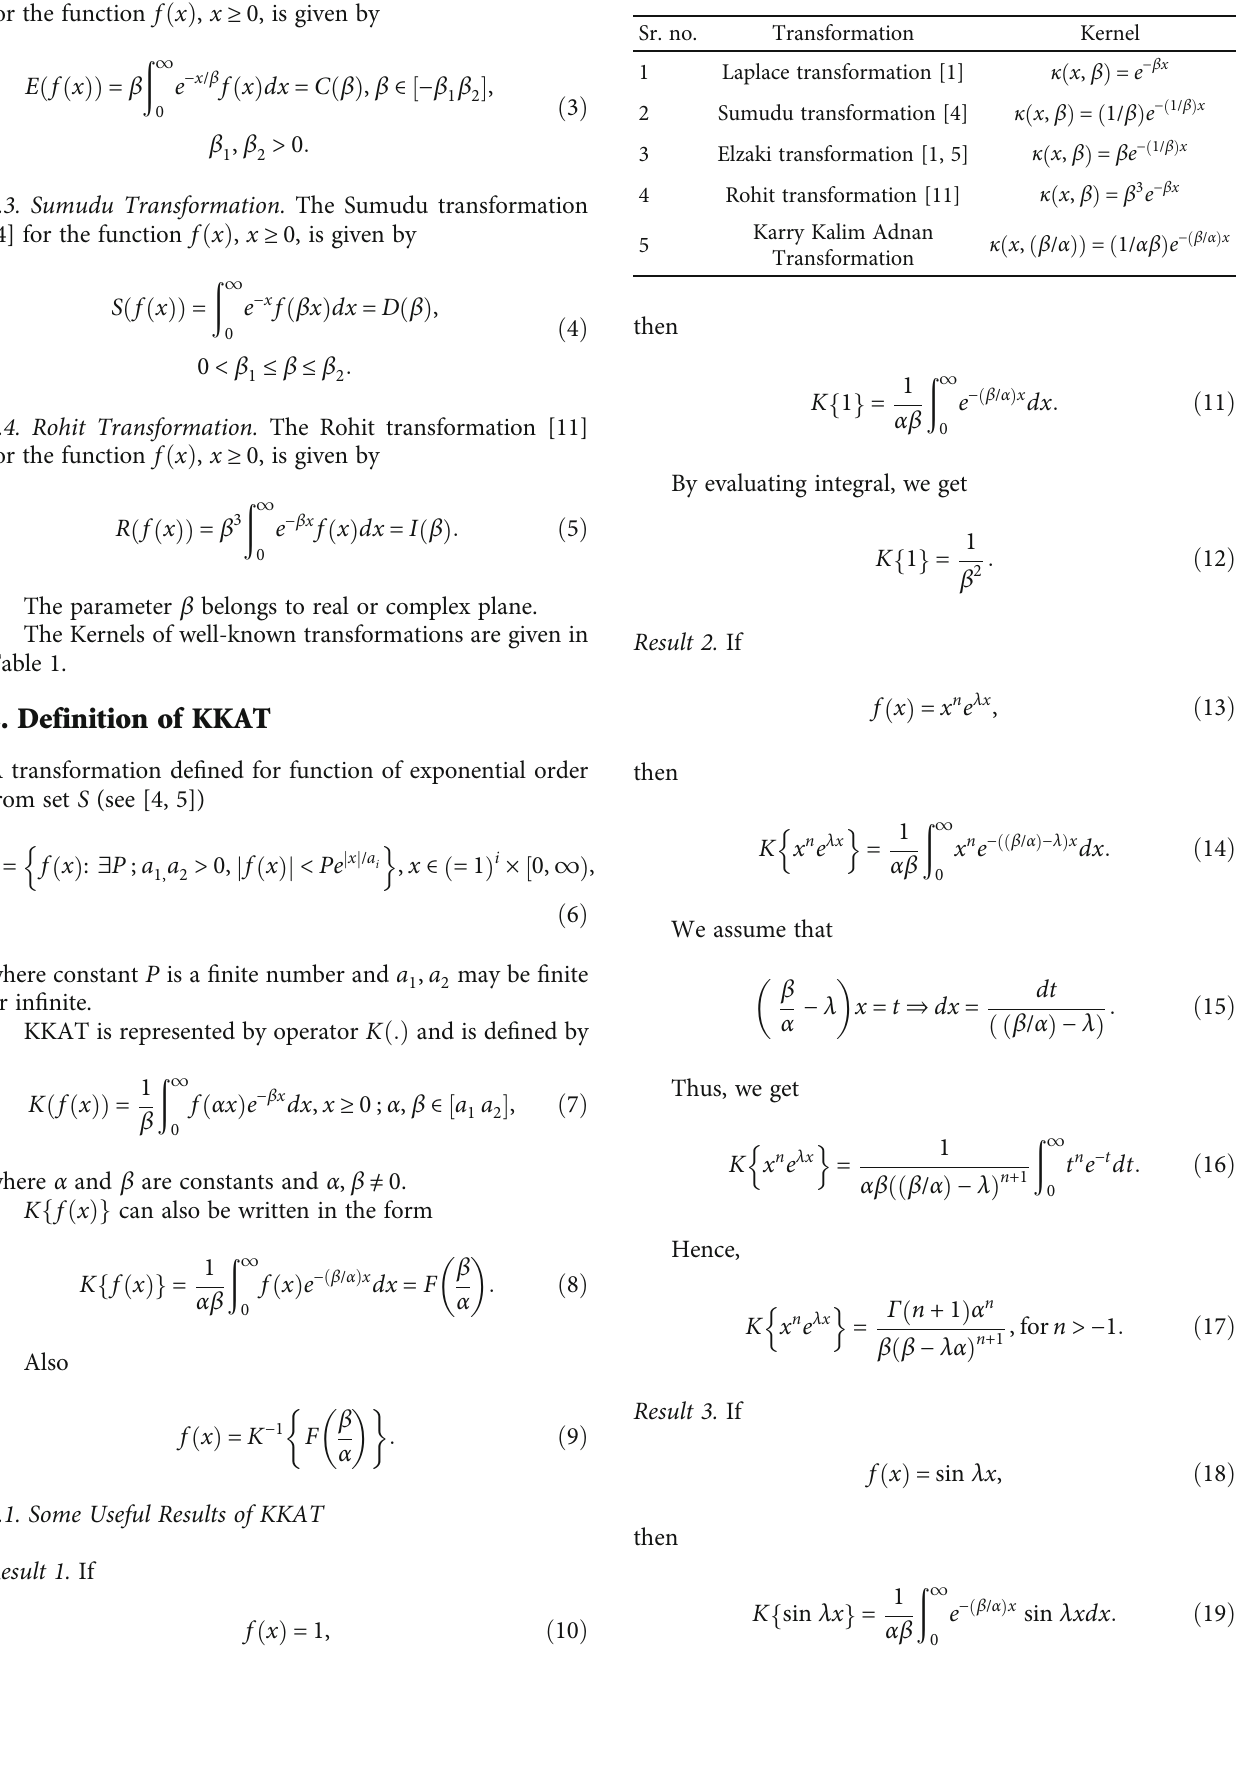
Table 1: Kernel of well-known